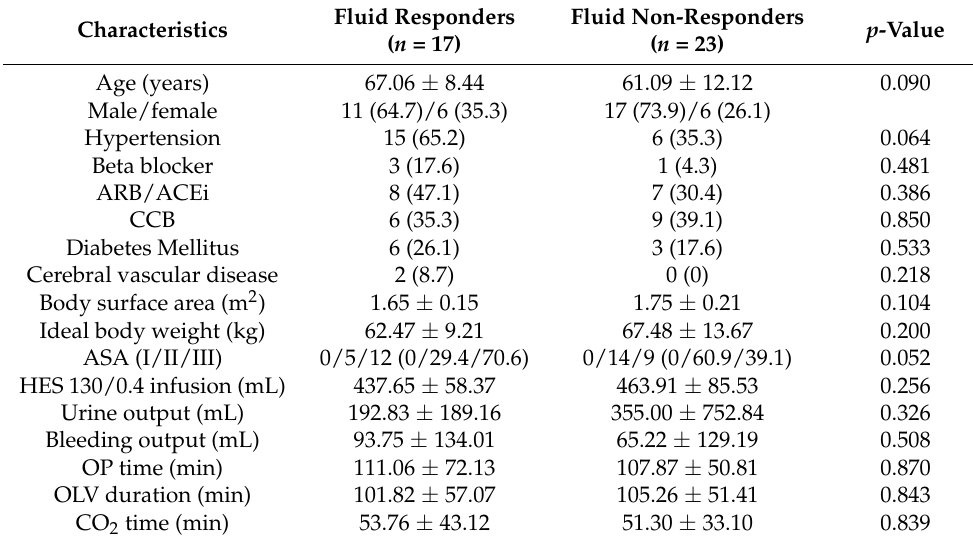
Table 1. Preoperative characteristics and intraoperative treatment.